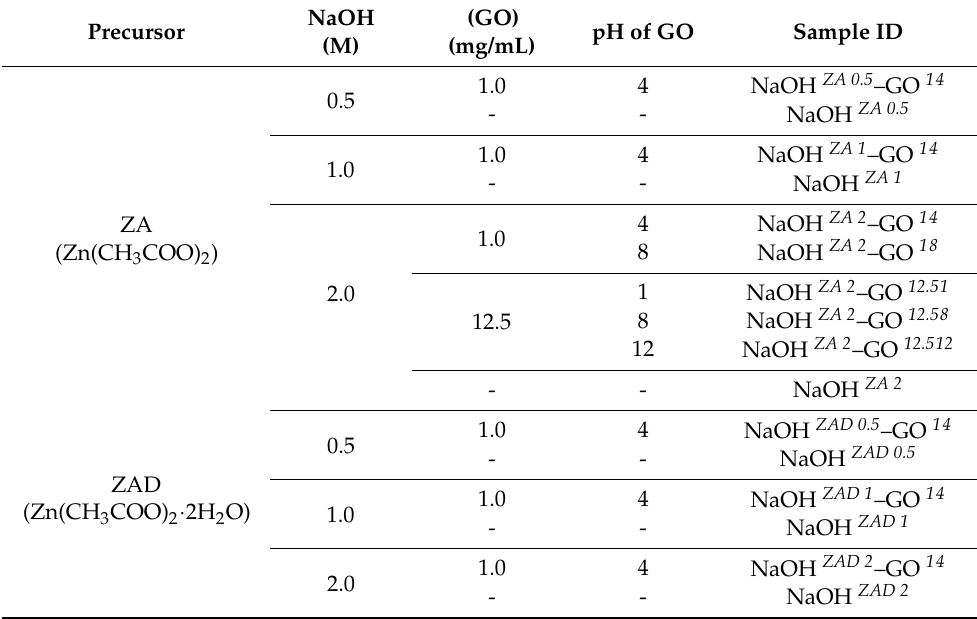
Table 1. Conditions of synthesis of ZnO and ZnO–rGO nanostructures: (i) zinc acetate precursors with different degrees of hydration (ZA and ZAD); (ii) presence or absence of GO at 1 mg/mL or 12.5 mg/mL; (iii) varying the NaOH concentration; and (iv) changing the pH of GO suspension. NaOH Precursor